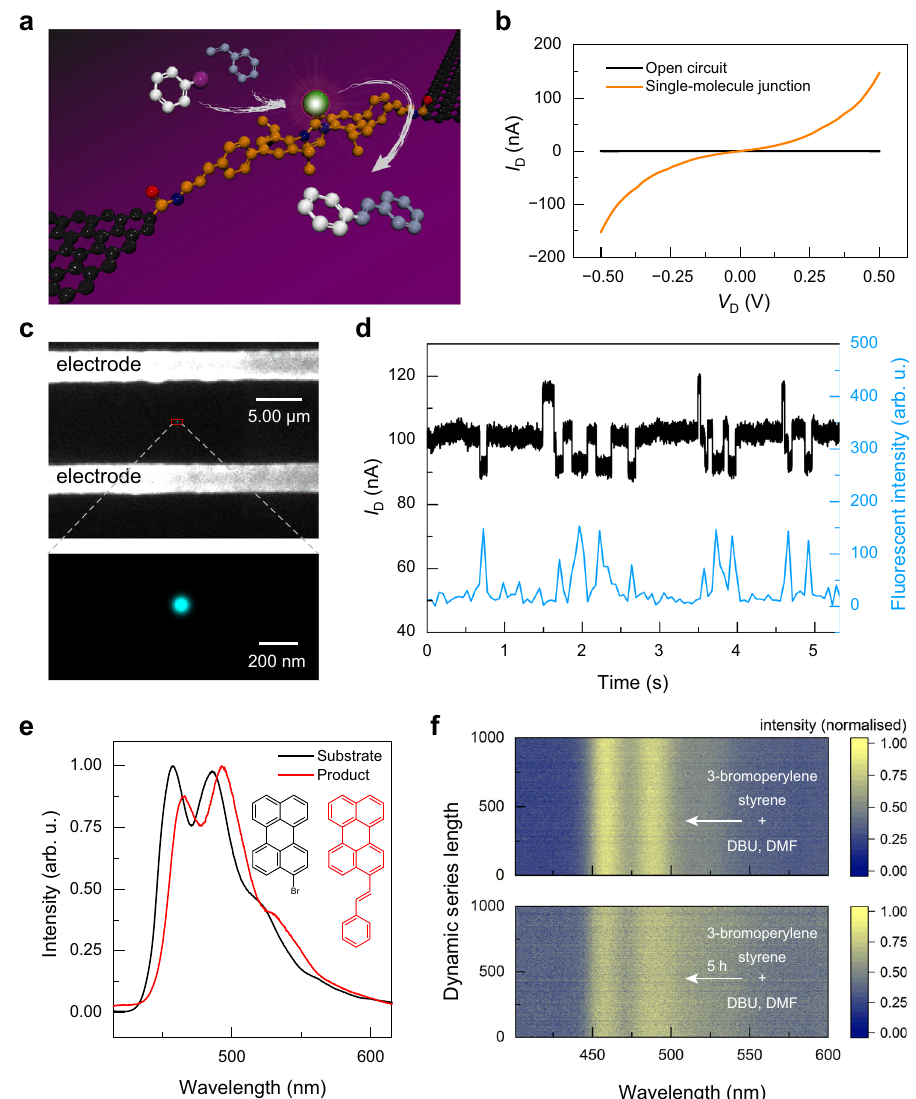
Fig. 1 | Preparation and characterisation of a single-molecule catalyst device. a Schematicofasingle-moleculedevicefortheMizoroki – Heckreaction.Blackball: carbon atom in graphene; brown ball: carbon atom in the molecular bridge; red ball: oxygen atom in the molecular bridge; dark blue ball: nitrogen atom in the molecular bridge; green ball: palladium atom in the molecular bridge; white ball: carbon atom derived from bromobenzene; purple ball: bromine atom in bromo- benzene;greyball:carbonatomderivedfromstyrene. b I – V curvesbeforeandafter preparation of the single-molecule device. The voltage response indicated the successful preparation of the single-molecule device. c Fluorescent super- resolution imaging of the single-molecule catalyst during the Mizoroki –